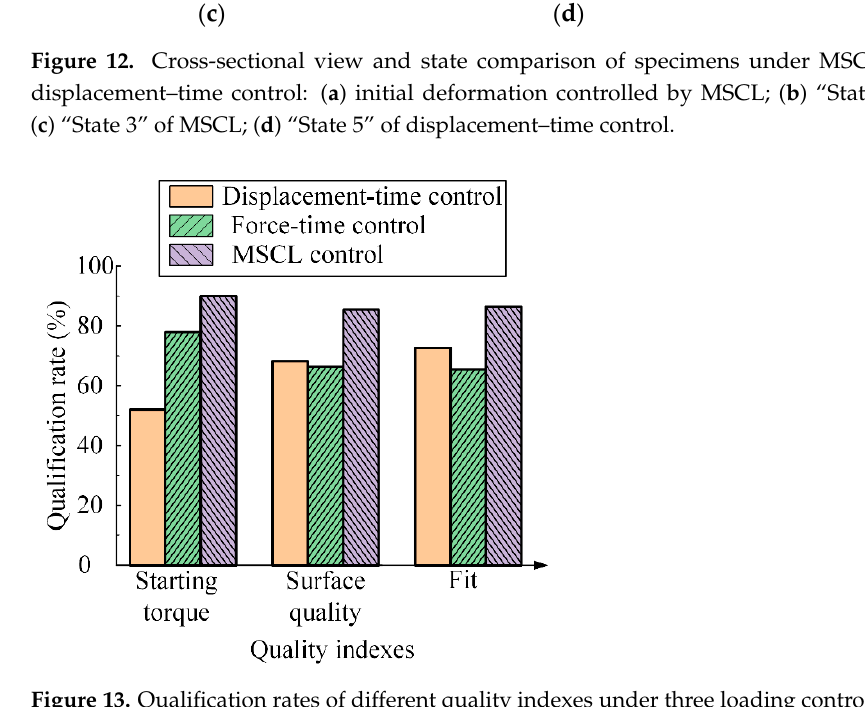
Figure 12. Cross-sectional view and state comparison of specimens under MSCL control and dis- placement–time control: ( a ) initial deformation controlled by MSCL; ( b ) “State 2” of MSCL; ( c ) “State 3” of MSCL; ( d ) “State 5” of displacement–time control.